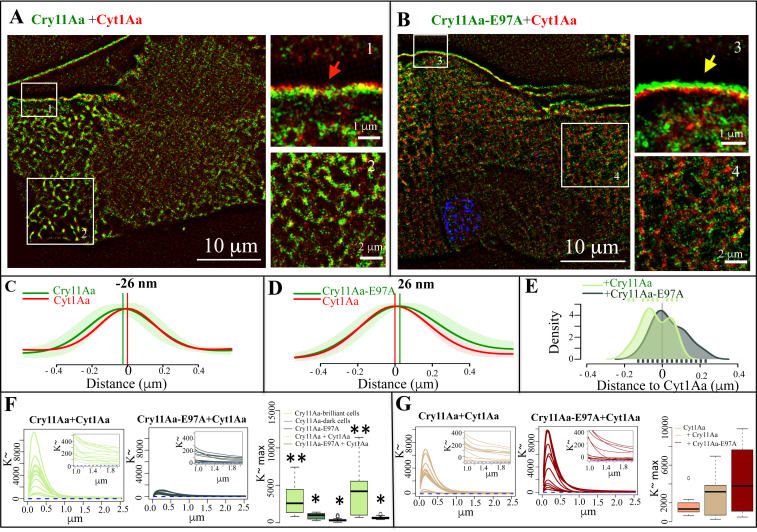
Nanoscopic in vivo organization of Cry11Aa or Cyt1Aa proteins during their synergism in the midgut tissue of Aedes aegypti larvae.Images were analyzed by high resolution SRRF microscopy. Larvae were fed 3 h with mixtures of crystal inclusions Cry11Aa-Alexa546 with Cyt1Aa-Alexa647 at 100 ng/mL of each protein (Panel A), and mutant Cry11AaE97A-Alexa546 with Cyt1Aa-Alexa647 at 1000 ng/mL + 500 ng/mL, respectively (Panel B). Larvae were processed as explained in Fig 6. Cry11Aa proteins were labeled with Alexa546 showing green fluorescence. Cyt1Aa proteins were labeled with Alexa647, showing red fluorescence. Panel A, shows one complete cell and one cell that is already broken down. Insets show selected images to improve clarity. Red arrowhead points to the specific Cyt1Aa-Alexa647 and Cry11Aa-Alexa546 proteins organization in apical membrane, where Cry11Aa-Alexa546 was located down facing the cell cytoplasm and Cyt1Aa-Alexa647 was found in the upper layer. Yellow arrowhead points to the inverted organization presented by Cry11AaE97A-Alexa546 mutant and Cyt1Aa-Alexa647. Panels C and D, show the quantitative line pattern analysis, where Cyt1Aa protein was arbitrary located at zero value, as described in Materials and methods, from more than 24 rectangles of 2.5 x 5 μm selected from Cry11Aa-Alexa546 with Cyt1Aa-Alexa647 mixture (Panel C), or from Cry11AaE97A-Alexa546 with Cyt1Aa-Alexa647 mixture (Panel D). Panel E, shows the distribution of the maximal distances of Cry11Aa and Cry11AaE97A to Cyt1Aa, which was arbitrarily located at zero value. Panels F and G, show the Ripley’s K-function statistical image analysis of the xy pattern organization observed in 14 selected 10 x 10 μm squares selected from different cells of the larvae intoxicated with the different mixtures of proteins. Panel F, shows the analysis of the fluorescence of Cry11Aa-Alexa546 or mutant Cry11AaE97A-Alexa546 in these mixtures and Panel G, shows the analysis of the fluorescence of Cyt1Aa-Alexa647 in these mixtures. Panels F and G, also show the Kruskal-Wallis test analyses of these distributions, different asterisks indicate significant different data (P value = 0.05), and no asterisks indicate any statistical differences.